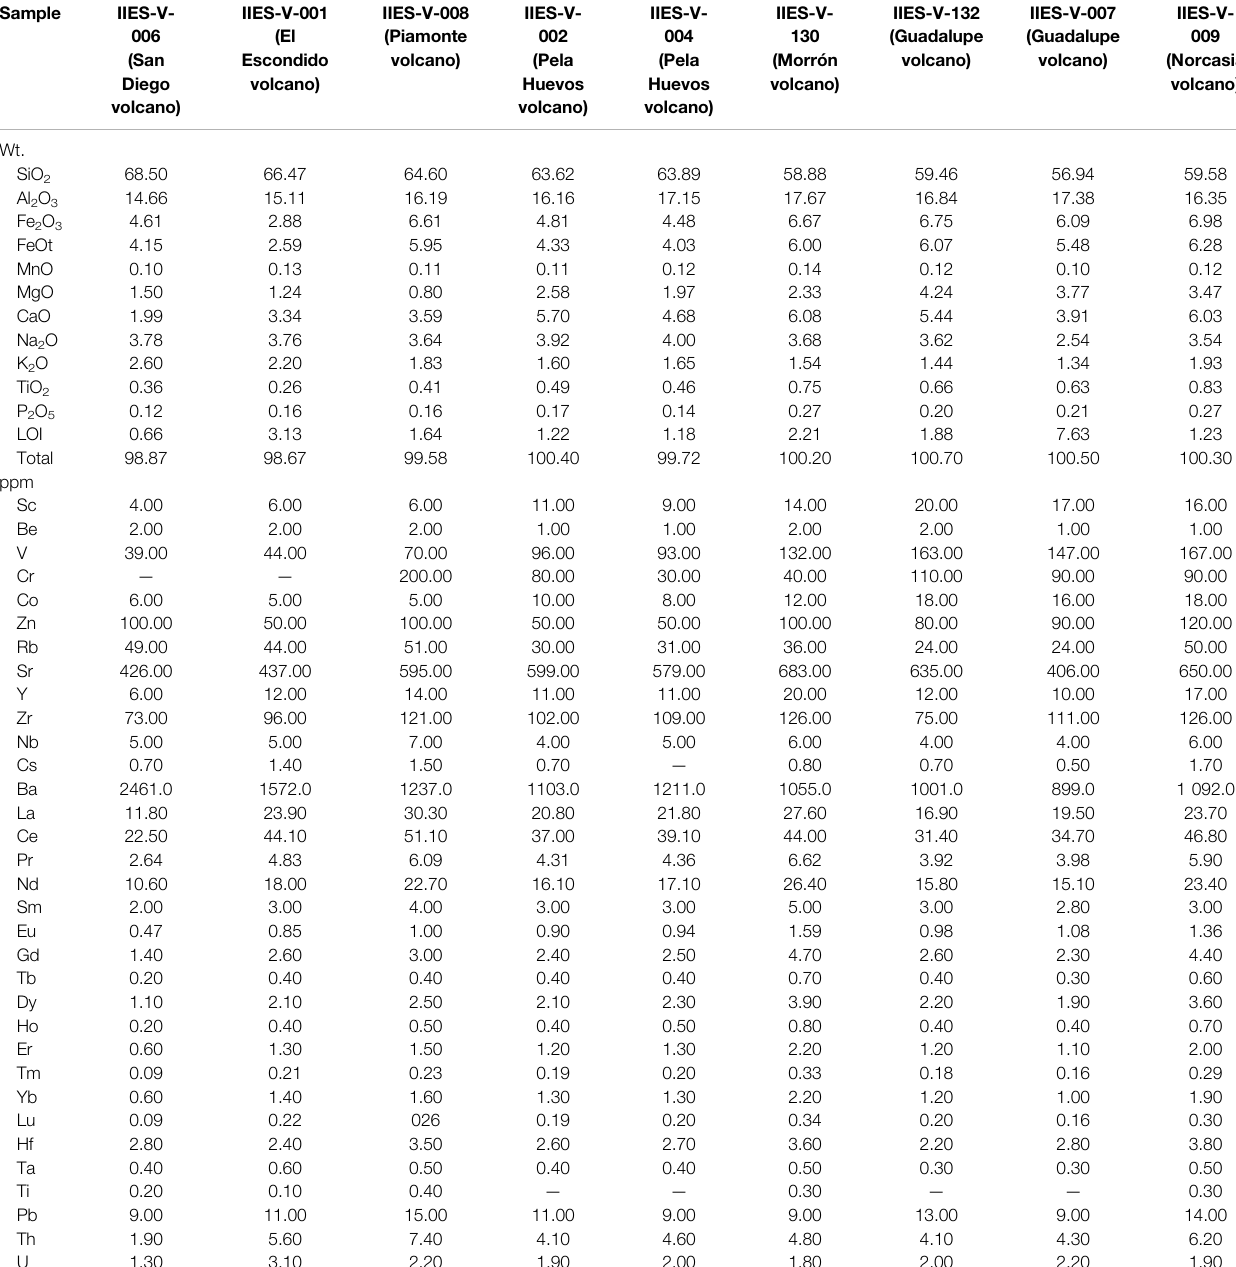
TABLE 3 | Whole-rock chemical data of investigated rocks of the Samaná monogenetic volcanic fi eld. Sample IIES-V- 006 (San Diego